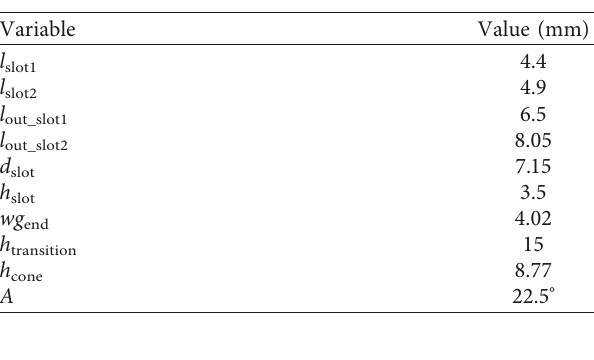
Figure 5: Twisting technique for enhancing the omnidirectional coverage. (a) Angle displacement definition. (b) Radiation pattern in the azimuth plane at 23.7GHz for distinct values of α. Table 1: Twisted SWAA final dimensions.